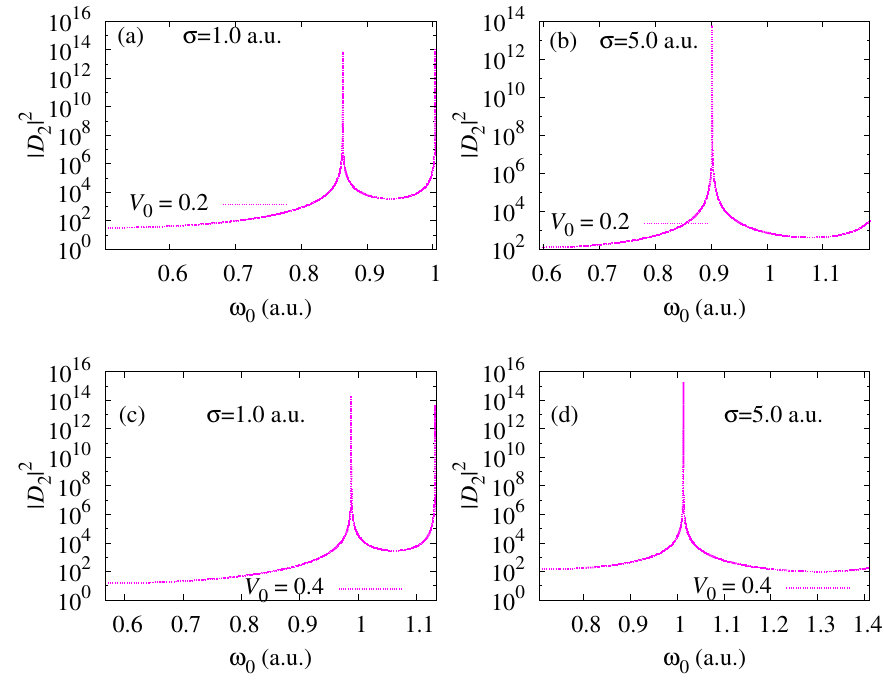
Figure 9. Variation of two-photon 1 s → 3 d absorption coefficients with frequency of incoming photons, ω 0 , for r 0 = 40 a.u. for ( a ) V 0 = 0.2 a.u. and σ = 1.0 a.u.; ( b ) V 0 = 0.2 a.u. and σ = 5.0 a.u.; ( c ) V 0 = 0.4 a.u. and σ = 1.0 a.u.; ( d ) V 0 = 0.4 a.u. and σ = 5.0